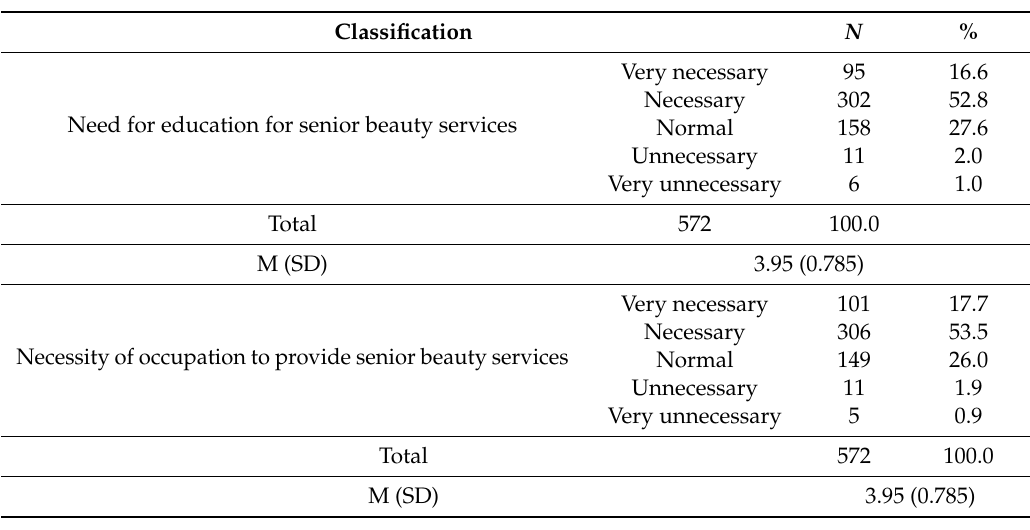
Table 2. Educational needs and necessity of occupation to provide senior beauty services.